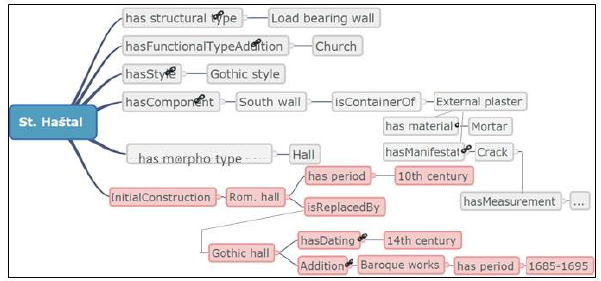
Figure 11. Object evolution profile